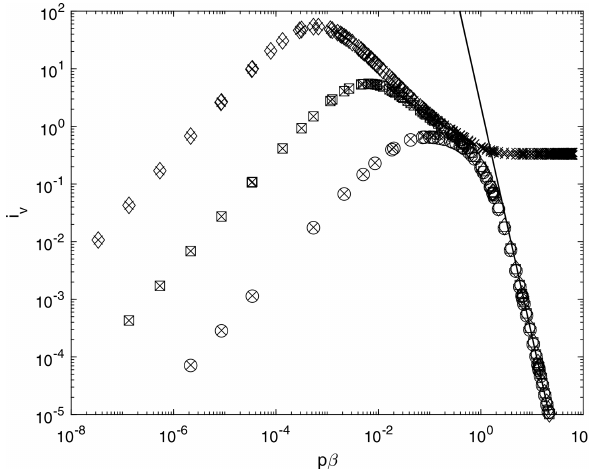
Figure 2. Integrand, i v , for p = 0 . 1, R 2 ∞ = 1 . 597. (cid:13) , x = 0 . 9; (cid:3) , x = 0 . 99 , ; and (cid:5) , x = 0 . 999 from Eq. (42). i v increases with x . × is the integrand in Eq. (45). For clarity, only every second data point is plotted. The solid line shows the remainders from Eq. (48). The differences with varying x are within the thickness of the